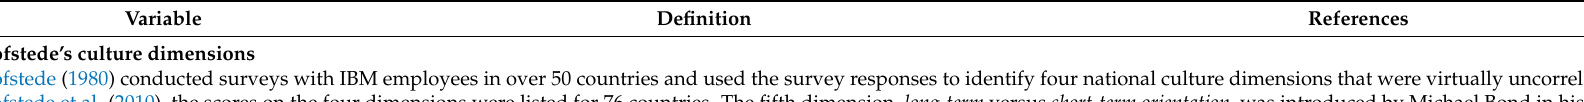
Table 1. Definitions of variables used in the